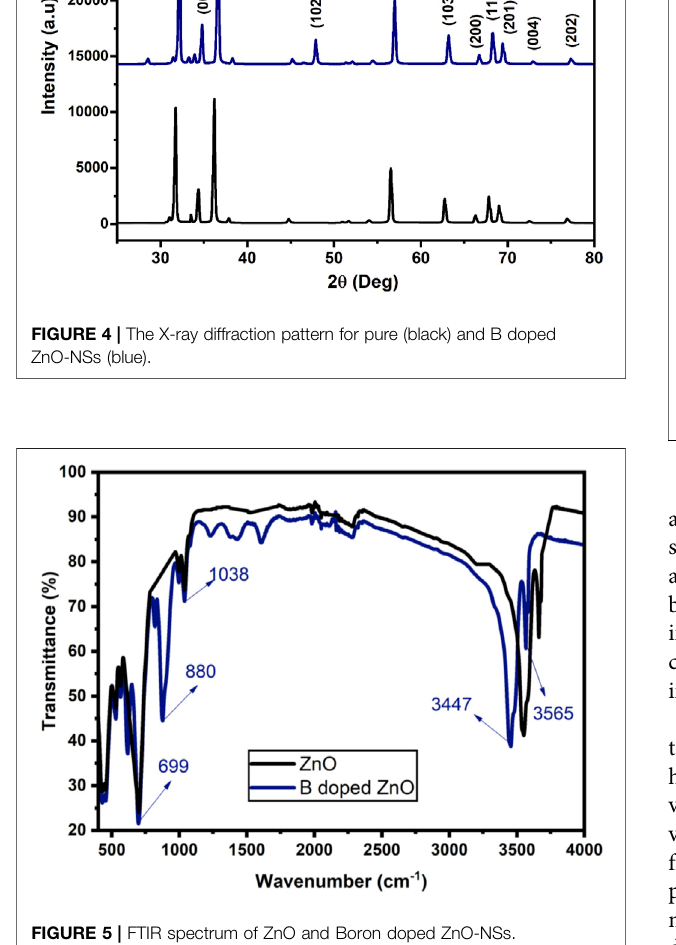
FIGURE 5 | FTIR spectrum of ZnO and Boron doped ZnO-NSs.